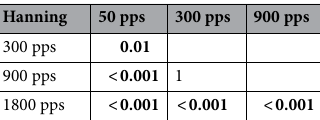
Table 2. p-values as in Table 1, but for Hanning windowed stimuli. Significant p-values (< 0.05) are shown in bold.